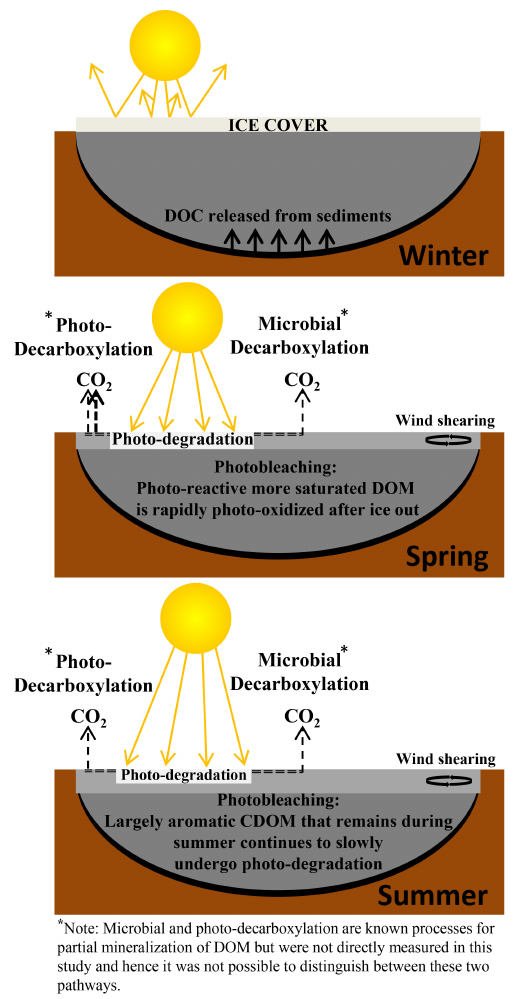
Fig. 9. Conceptual framework of (C)DOM transformation in a bo- real lake based on FT-MS analysis of SPE-DOM and photochemical degradation